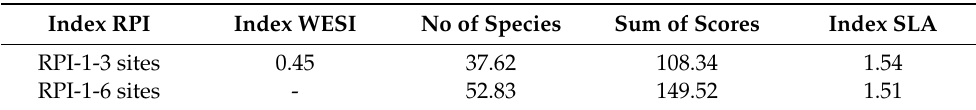
Figure 8. Water Ecosystem State Index (WESI) in the Zarafshan River, 2009–2015 on the base of Indices saprobity according Sláde č ek (SLA) and Nitric-nitrogen concentration. Norm line is the critical value of WESI indicated start of toxic impact if WESI value is below 1. Table 5. River Pollution Index (RPI) for biological variables from 1–3 sampling sites and for 1–6 sites The River Pollution Index (RPI), according to Sumita, was calculated for Index Sap- in the Zarafshan River, 2009–2015. robity (SLA) (Table 1), WESI, and the biological variables (Table 2). Table 5 shows RPI’s